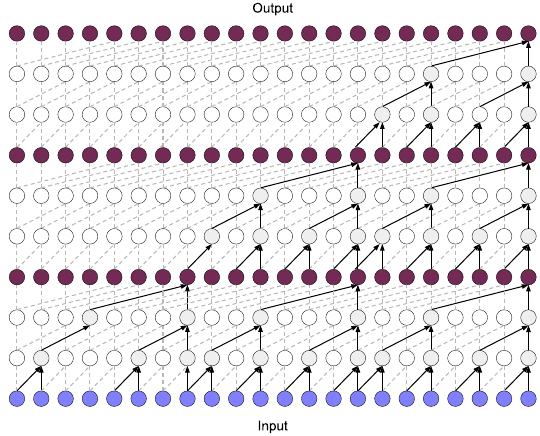
Figure 5. Temporal Convolutional Networks (TCN) model with 3 stacked blocks. Each block has 3 convolutional layers with kernel size 2 and dilations [1, 2,